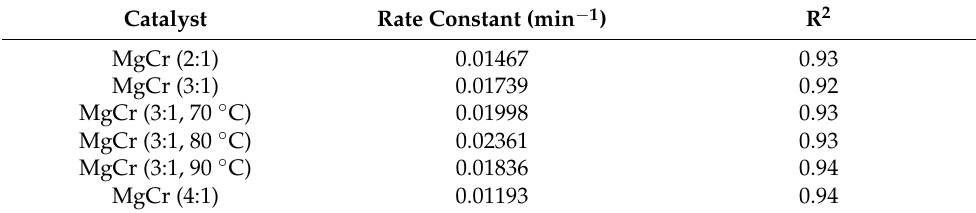
Figure 7. ( a ) Kinetics of RhB degradation by linear fitting of C 0 /C vs. time using a series of exfoliated MgCr − LDH samples. ( b ) Histogram showing % of degradation using different scavenging agents. ( c ) Absorbance plot of NBT by MgCr − LDH (3:1, 80 °C). ( d ) PL spectra of MgCr − LDH (3:1, 80 °C) by TA. Table 1. Rate constant and regression co-efficient value of exfoliated MgCr-LDH NS.